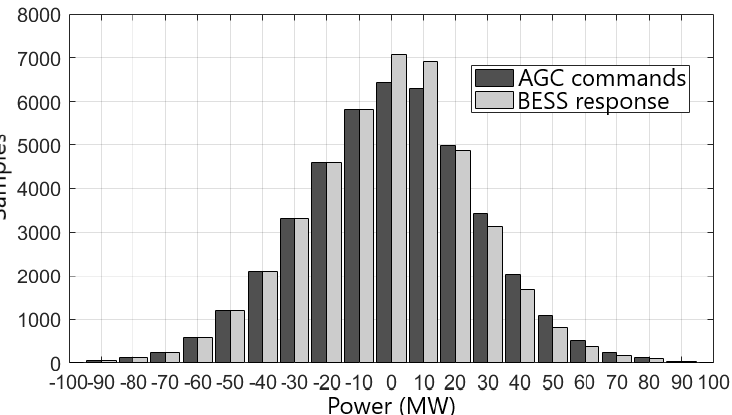
Figure 9. One hundred MW, 3 h BESS response and AGC commands for 18 GW of wind power scenario.